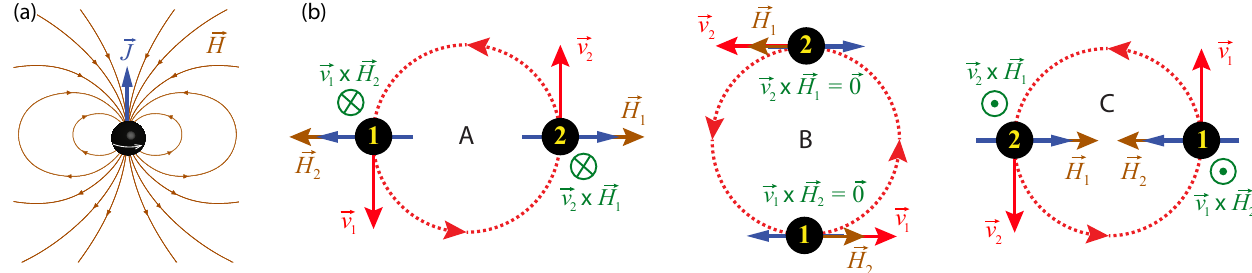
Figure 4. ( a ) The field lines of the gravitomagnetic field (cid:126) H produced by a spinning black hole (of spin vector (cid:126) J ); it is similar (far from the BH) to that of a magnetic dipole oriented oppositely to (cid:126) J . ( b ) The actual picture of the corresponding spin-orbit gravitomagnetic forces M (cid:126) v × (cid:126) H involved in the bobbing motion, with phase D suppressed, since the result is similar to B. The situation is opposite to that in Figure 3: the forces vanish when the spins are orthogonal to the axis connecting the black holes (phases B and D, as therein (cid:126) v 1 (cid:107) (cid:126) H 2 , (cid:126) v 2 (cid:107) (cid:126) H 1 ), and have maximum magnitude when they lie along such an axis, pushing the pair out of the plane of the illustration in phase A, and inwards in phase